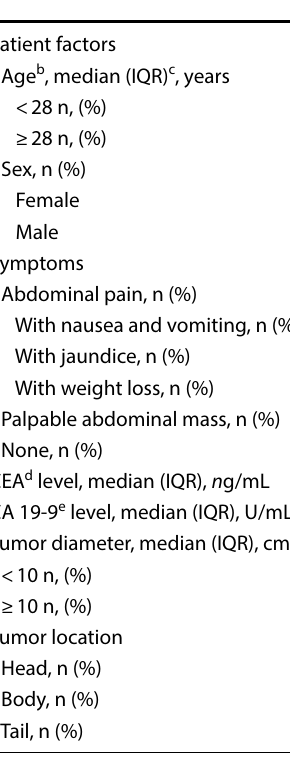
Table 1 Clinical characteristics in 74 patients with solid pseudopapillary neoplasm who underwent